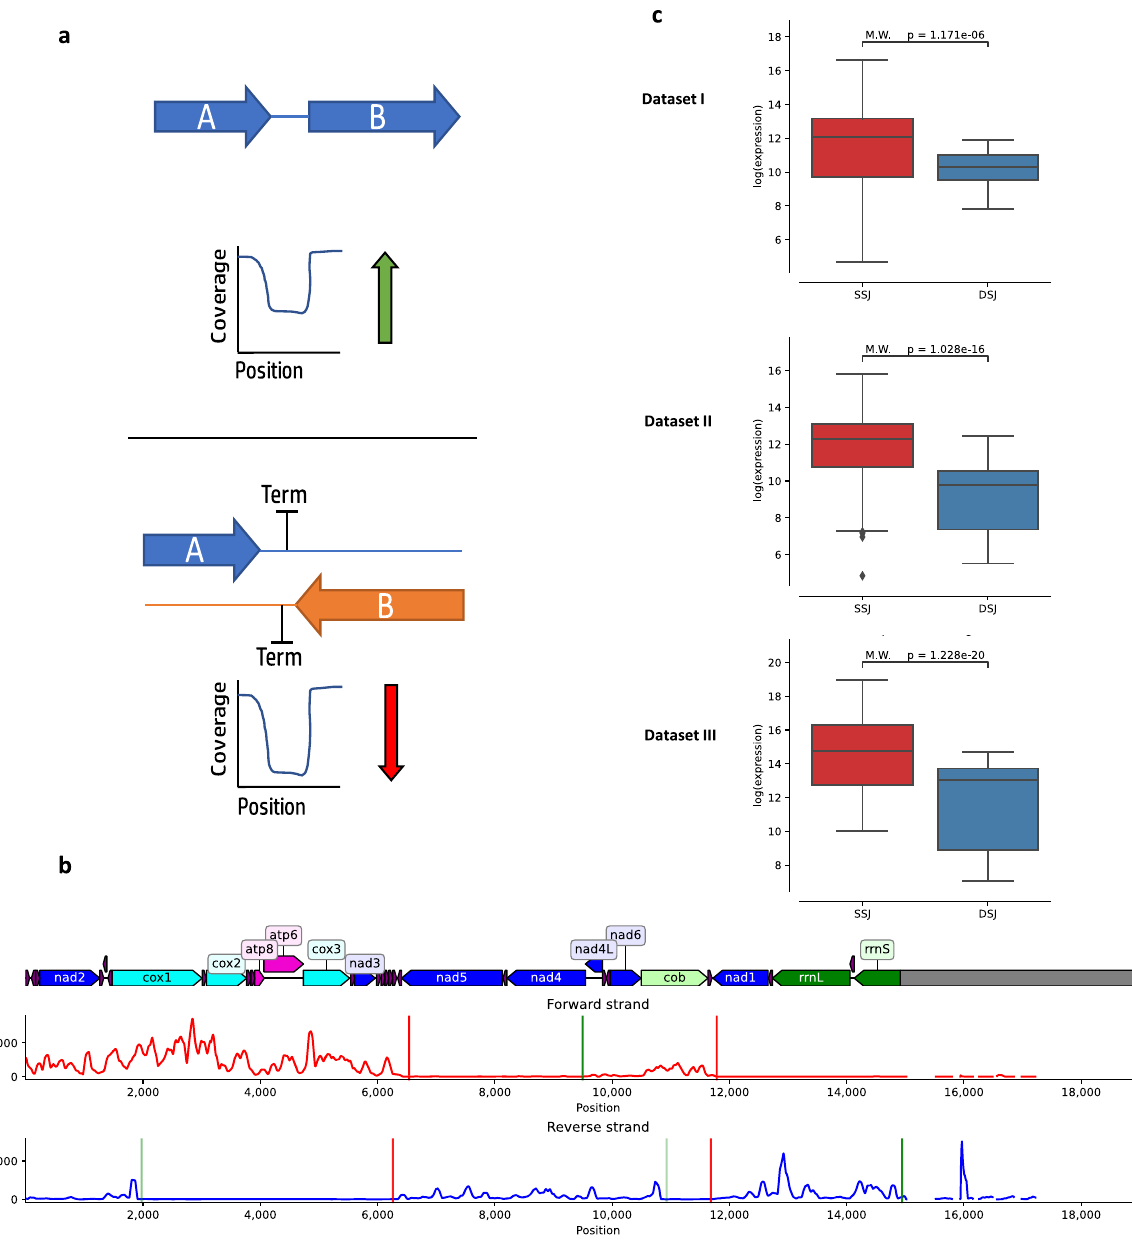
Fig. 4 Gene-gene junctions represent borders between polycistronic units in Drosophila melanogaster. a An illustration of the expected expression level in junctions between genes from the same strand (SSJ) as compared to junctions between genes encoded by different strands (DSJ). b Analysis of mtDNA sequence read coverage from precision run-on sequencing (PRO-seq) experiments in Drosophila. Forward strand read coverage is colored in red and the reverse strand in blue. Vertical green and red lines mark the predicted transcriptional initiation and termination sites, respectively. The level of vertical line transparency depends on the prediction ’ s con fi dence score (see Methods). The numbers below each line correspond to mtDNA positions. c Boxplot comparisons of log normalized expression between DSJ and SSJ in three different Drosophila RNA-seq datasets (See Supplementary Data S2). Each box extends from the 25th to the 75th percentiles, whiskers denote values within 1.5 interquartile range of the percentiles. Dots denote outliers outside of